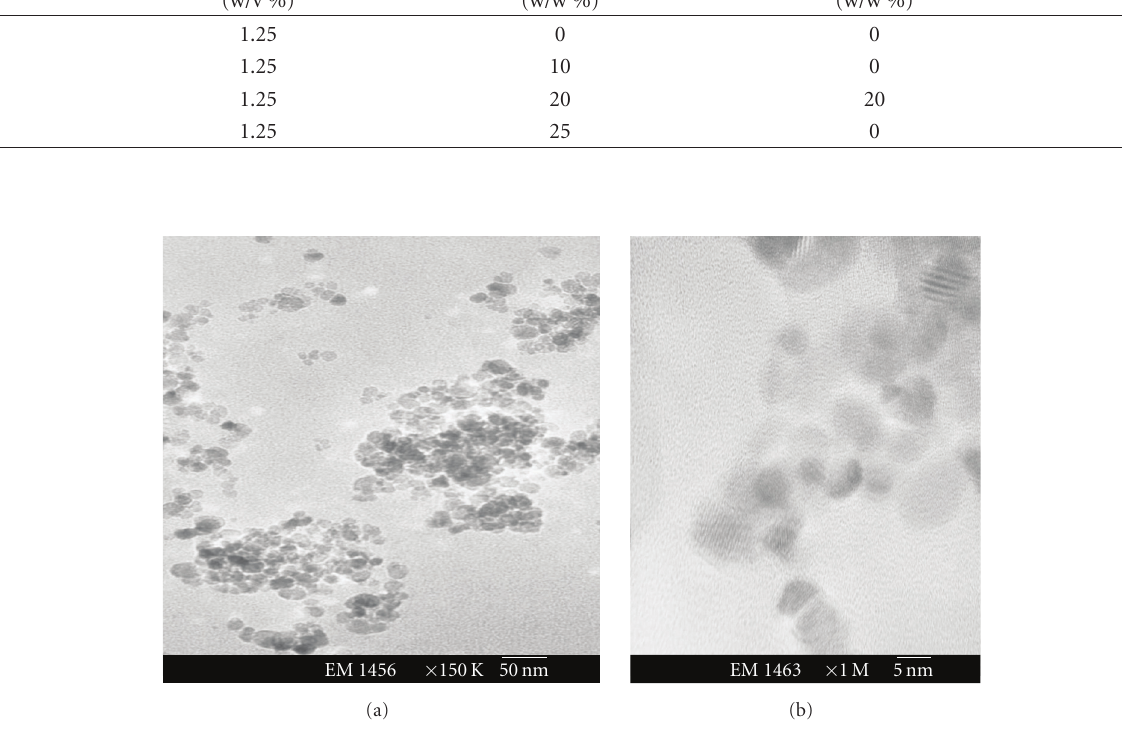
Table 1: Formulation of nanocomposite samples and their size distribution determined by DLLS. Sample no.